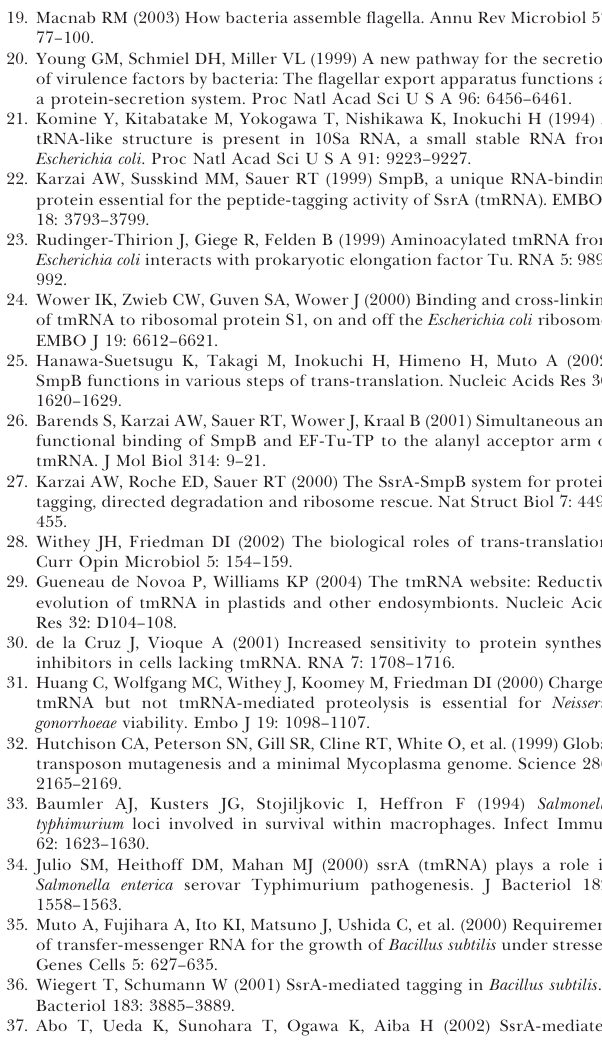
Table S1. Oligonucleotide Primers Used in This